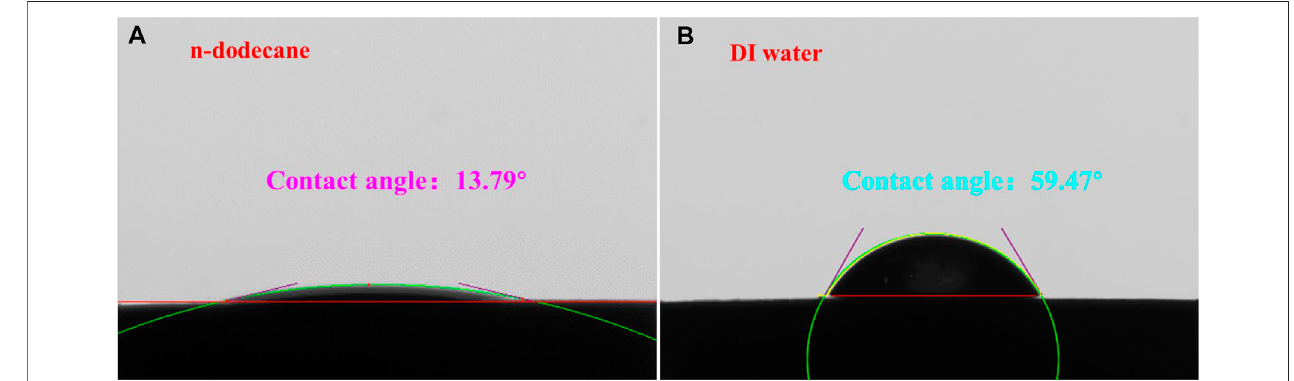
FIGURE 5 | Air-liquid contact angle droplet tests: (A) n-dodecane; (B) DIW liquids.